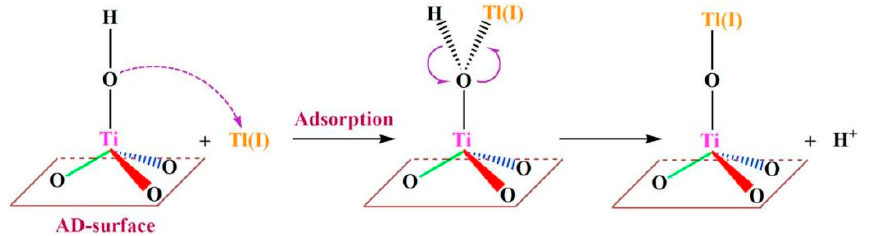
Figure 9. Tl removal mechanism by titanium peroxide